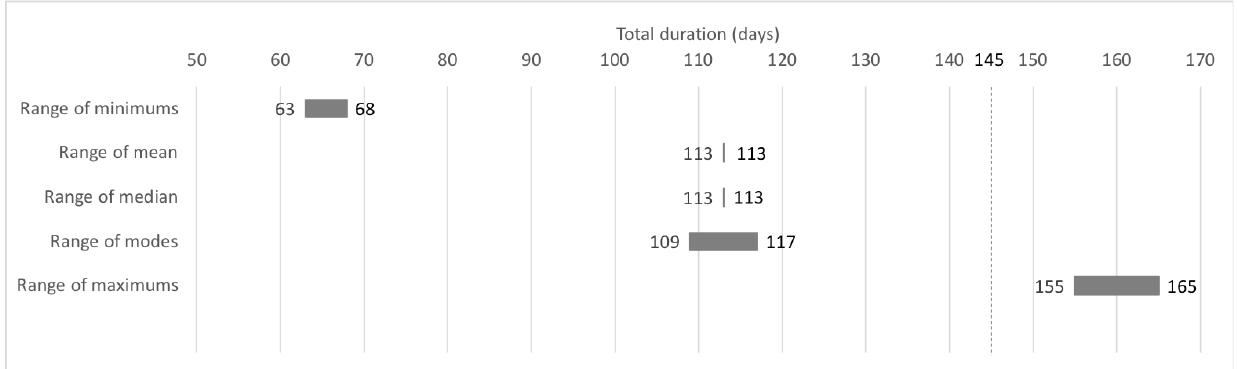
Figure 3. Summary of the statistics for the impact on total duration (ten simulation runs). Modified from [37].